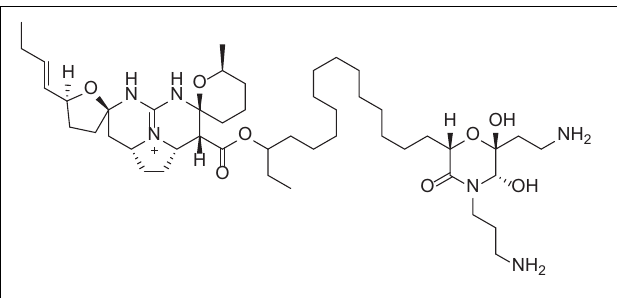
FIGURE 1 | Structure of monanchocidin